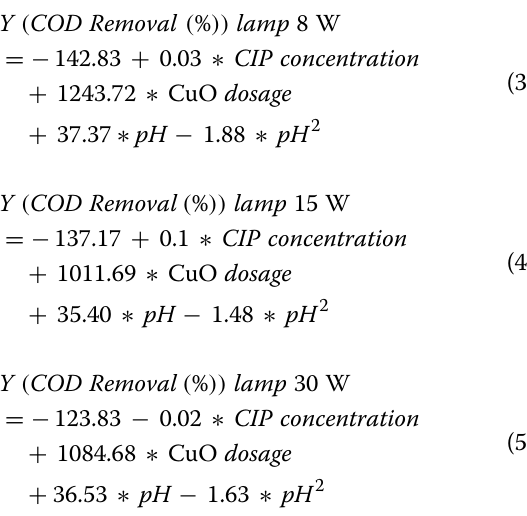
Table 6 Optimization results for independent variables and responses in predicted and experimental values Optimum